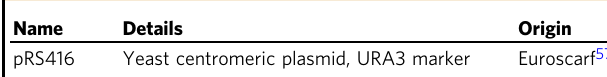
Table 1 Plasmids used in this